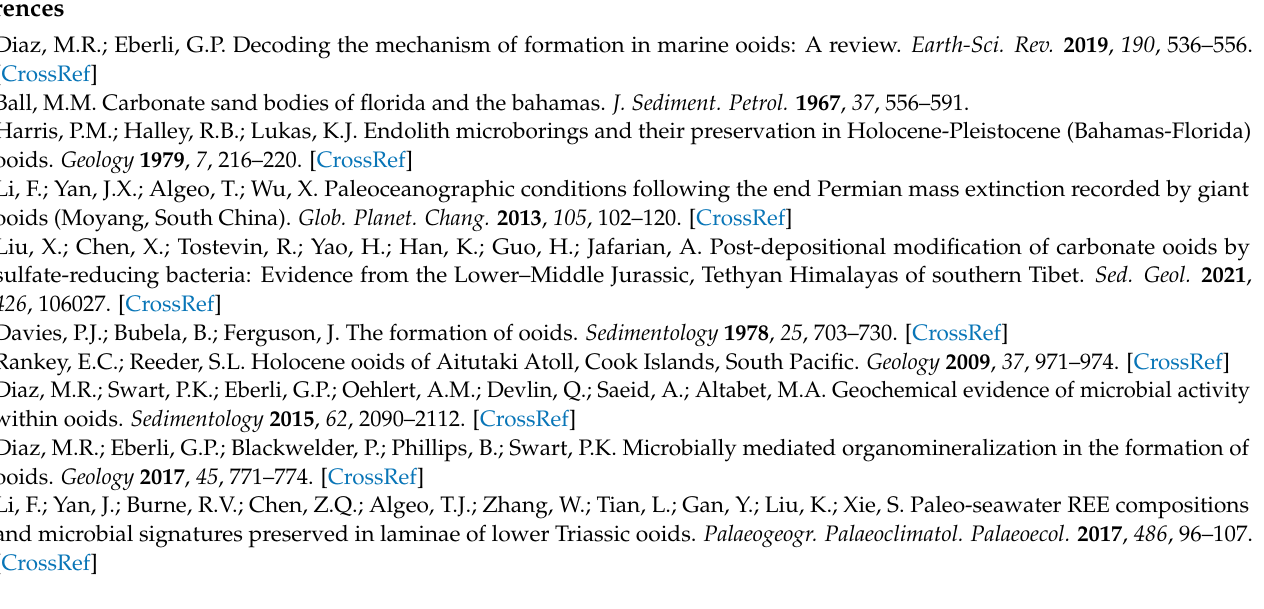
sample; Figure S2: EDS spectra for minerals corresponding to those of Figure